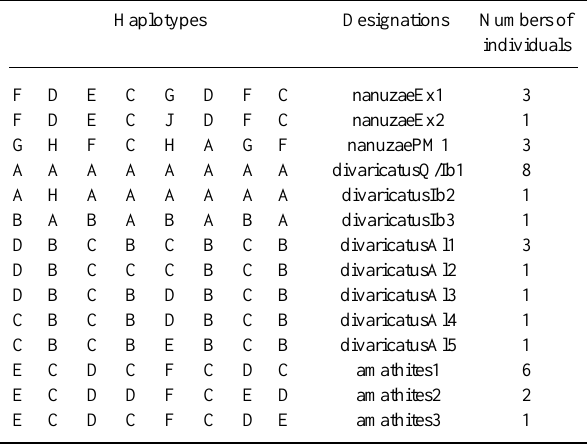
Table II - Haplotypes of the Tropidurus nanuzae group populations analyzed. Capital letters refer to the digestion profiles of Bcl I, Dra I, Eco RI, Eco RV, Hin dIII, Pst I, Pvu II and Xho I, from left to right. The haplotypes are designated by the name of the species, followed by the locality abbreviations (Ex = Extração; PM = Pedra Menina; Q = Queimadas; Ib = Ibiraba; Al = Alagoado). Haplotypes are numbered according to frequencies.